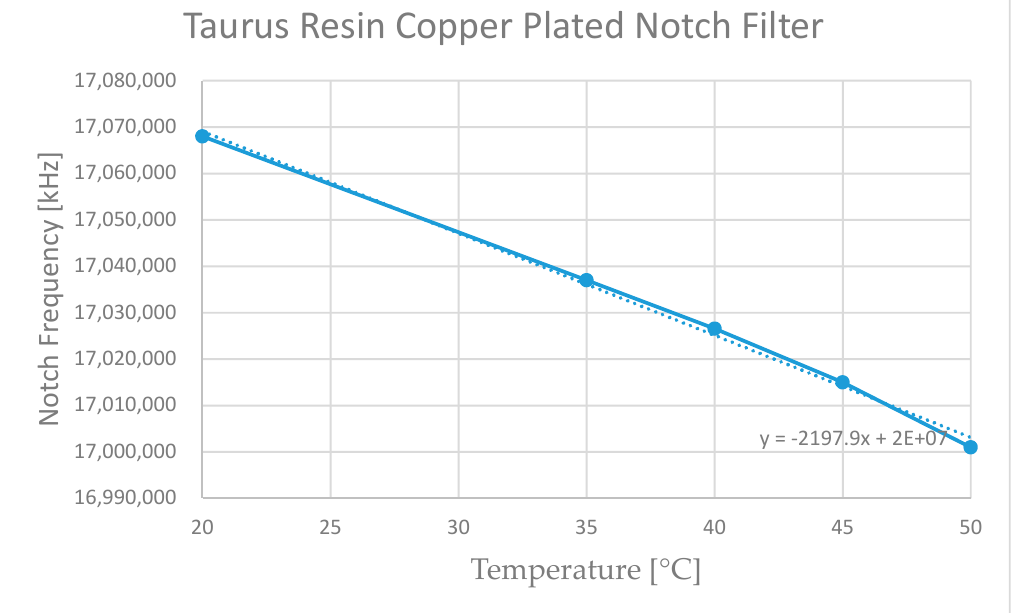
Figure 8. Somos Taurus SLA 3D printed copper plated notch filter.